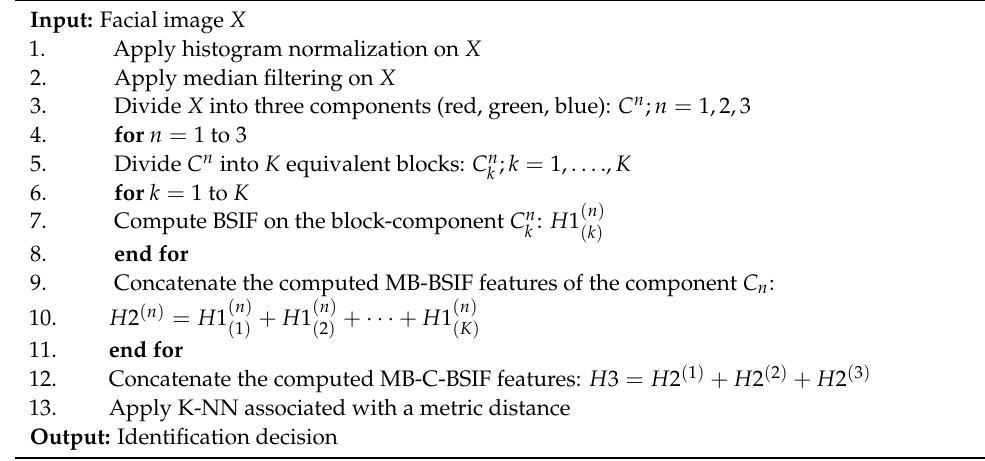
Algorithm 1 SSFR based on MB-C-BSIF and K-NN